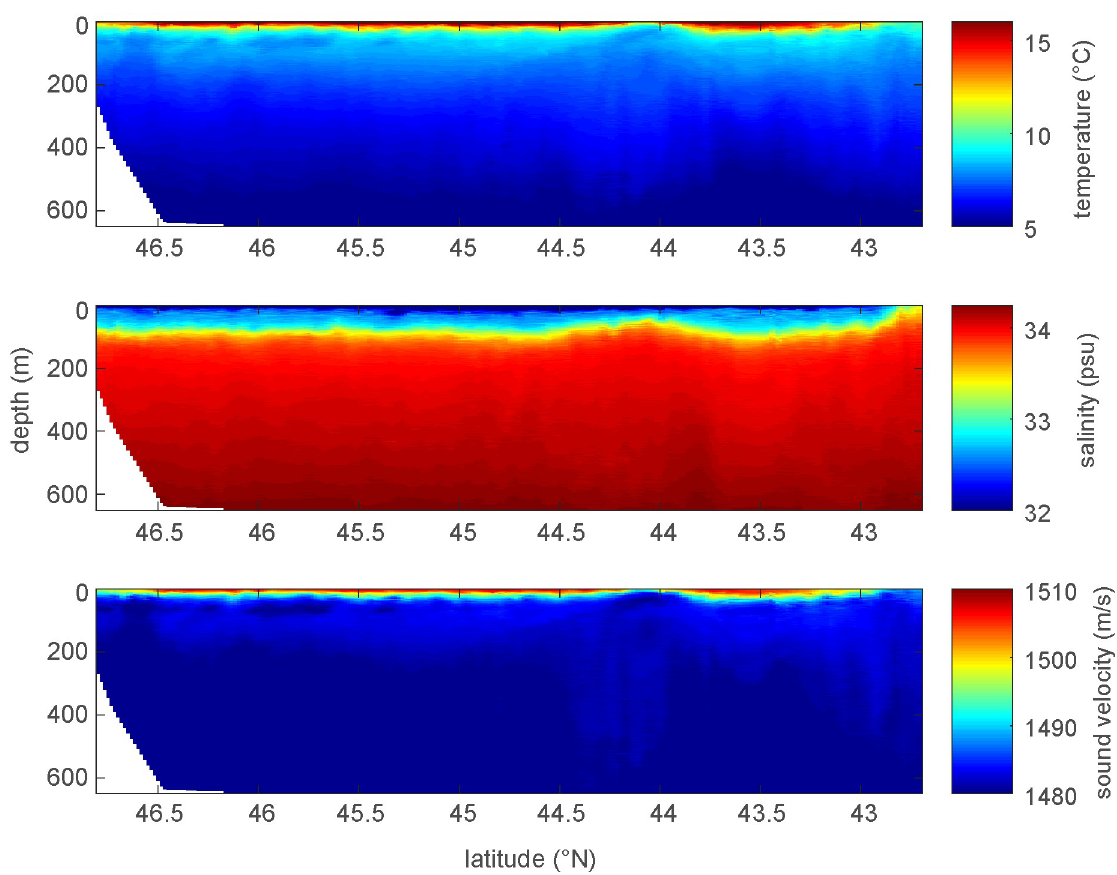
Fig 2. Two-dimensional cross sectional views of environmental data collected along the glider flight path. Water temperature (upper), salinity (mid), and calculated sound velocity (lower) measurements show the 2-D spatial structure of water column properties along the continental shelf break to 650 m